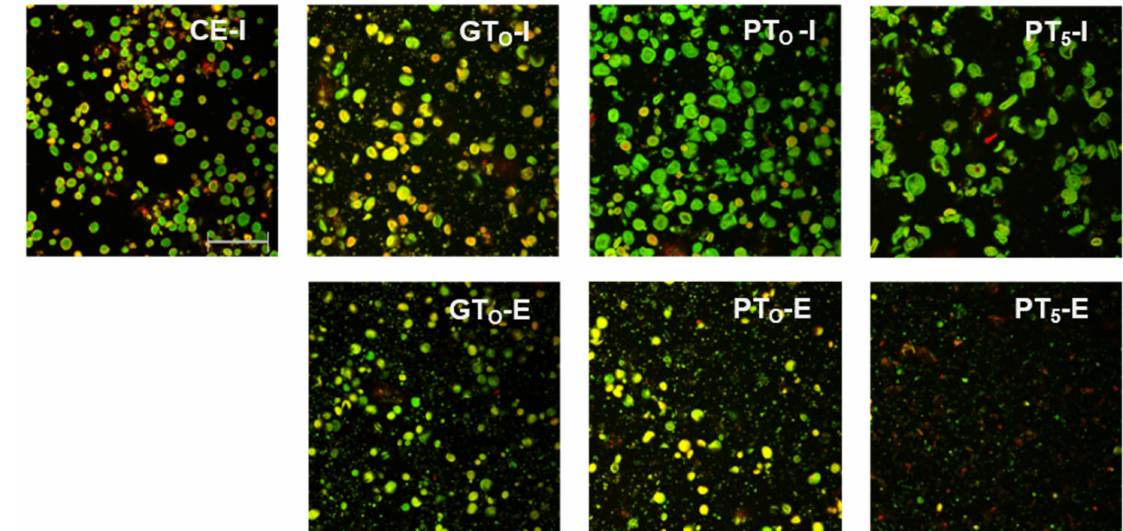
Figure 3. CLSM micrographs of inhibited (I) and enzymatic (E) barley malt samples after isothermal mashing for 5 min at sample specific temperatures levels. Abbreviations: CE: cold extract, GT O: gelatinization onset temperature, PT O : pasting onset temperature, PT 5 : unadjusted pasting onset temperature. Scale bar refers to 200 µ m. Table 2. Impact of micro-mashing on the evolution of viscometric characteristics (IV initial viscosity, PV peak